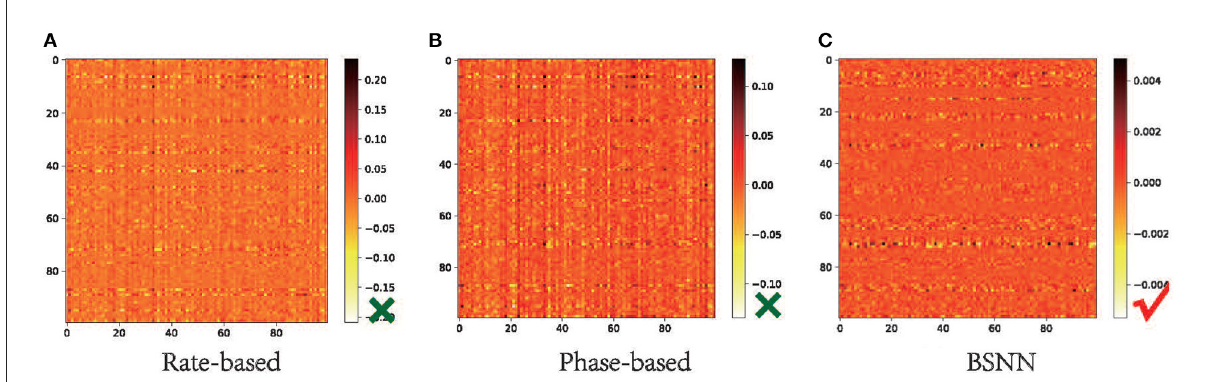
FIGURE5 Output difference between ANN and converted SNN on CIFAR-100. We compare the output rate of 100 samples of VGG16 with the output firing rate of three conversion methods to verify that the reason for BSNN to improve network performance lies in better approximation. (A) Rate-based. (B) Phase-based. (C) BSNN.